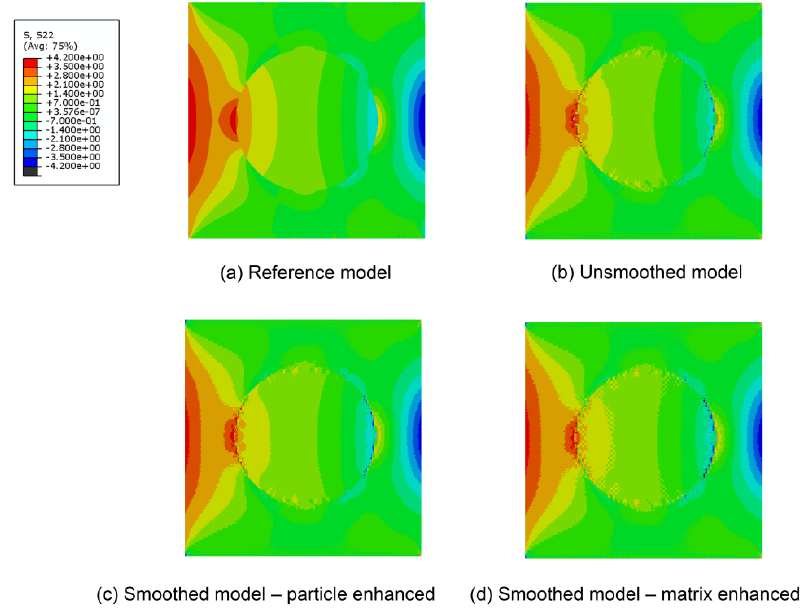
Figure 9. y -directional stress distributions: ( a ) reference model; ( b ) unsmoothed model; ( c ) smoothed model-particle enhanced; ( d ) smoothed model-matrix enhanced.